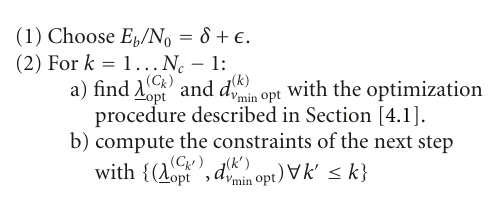
Algorithm 2: Hierarchical UEP optimization algorithm.